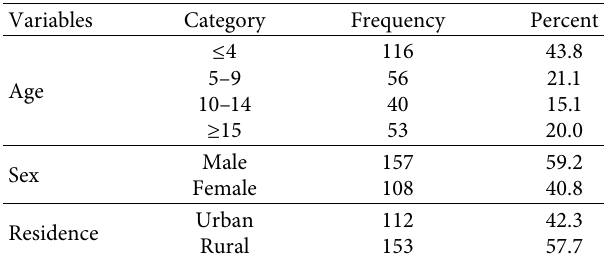
Table 1: Sociodemographic characteristics of pediatric surgical patients admitted to Arbaminch General Hospital from January